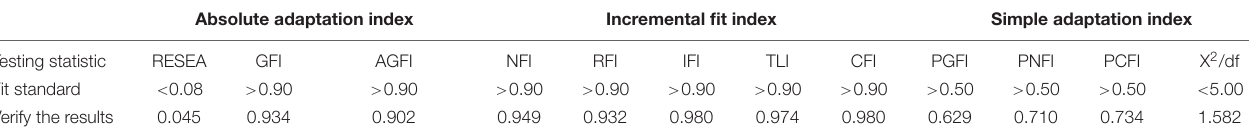
TABLE 3 | Index fit.